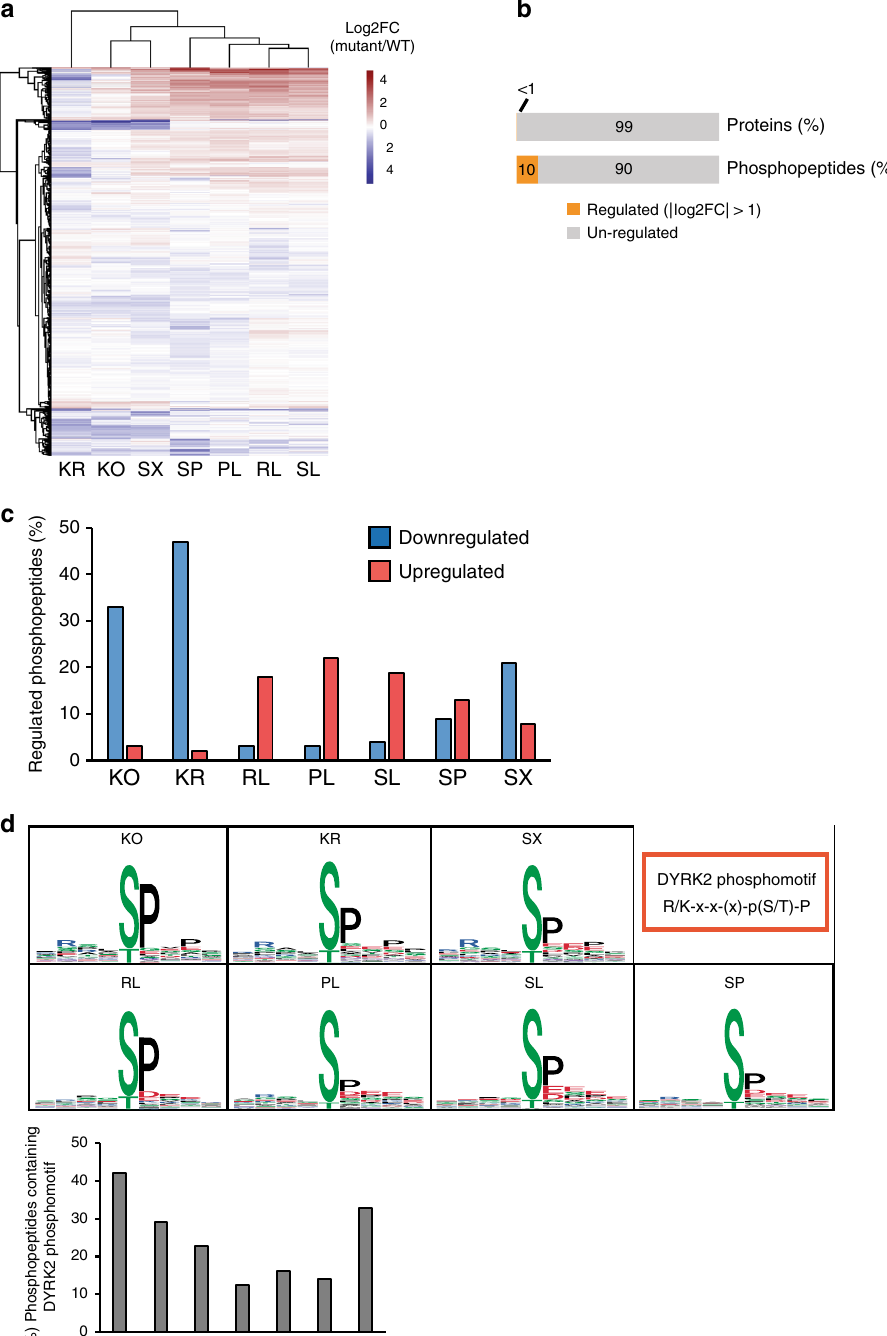
Fig. 6 The molecular footprint of Dyrk2 cancer-related mutations on the cellular phosphoproteome. a Heatmap with hierarchical clustering illustrating changes in the abundance of cellular phosphopeptides across the different cancer-related Dyrk2 point mutants. Only those peptides that have been detected at least once as statistically signi fi cantly changed (adj. p -value ≤ 0.01, │ log2FC │ > 0.5) are displayed. b Content of regulated proteins and phosphopeptides summarized from all Dyrk2-mutant cell lines (regulated phosphopeptides: │ log2FC │ > 1, adj. p -value ≤ 0.05). c Fraction of signi fi cantly upregulated or downregulated localized phosphopeptides in cell lines expressing the Dyrk2 point mutants ( │ log2FC │ > 1, adj. p -value ≤ 0.05). d Phosphomotif analysis of downregulated phosphopeptides in the different Dyrk2 variants (adj. p -value ≤ 0.05) (left panel). Fraction of downregulated phosphopeptides containing the Dyrk2 phosphomotif (right panel). The statistical analysis and p -value calculation (adj. p -value (FDR)) was performed within the mapDIA package 60 . Source data are provided as source data fi